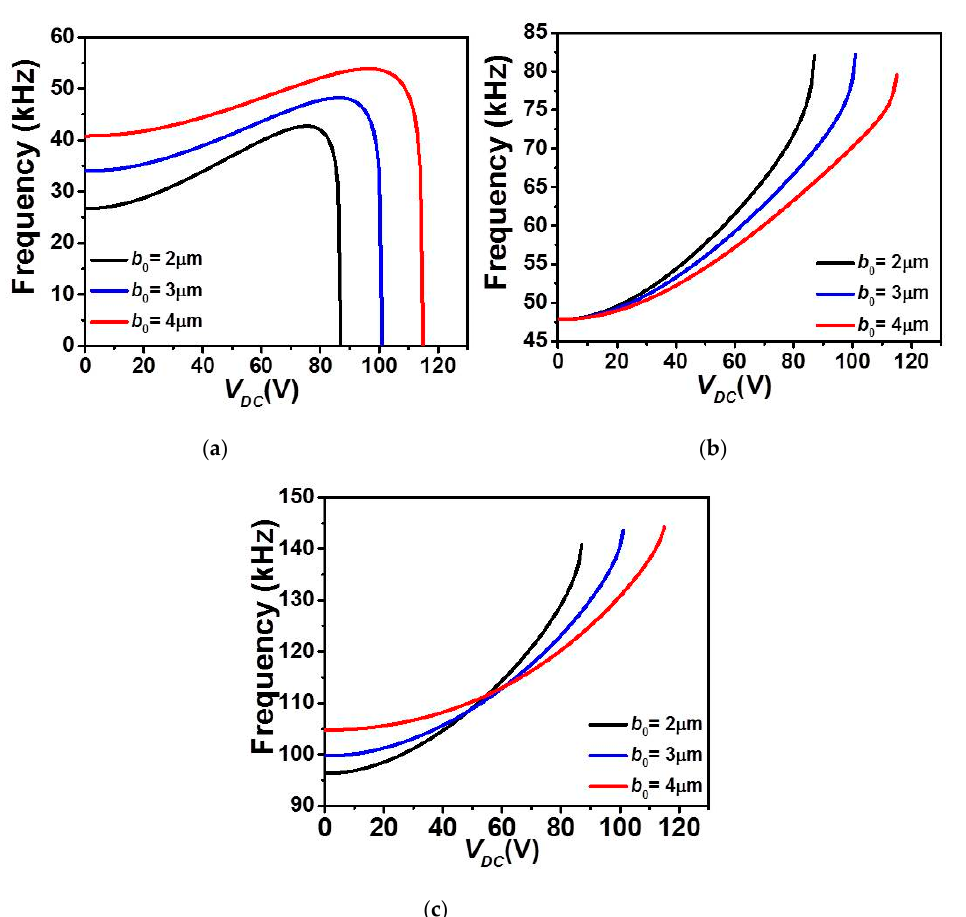
Figure 8. The variation of the ( a ) first, ( b ) second, and ( c ) third in-plane flexure natural frequencies for Case 2 as varying V DC with uniform g and for various values of b 0 .